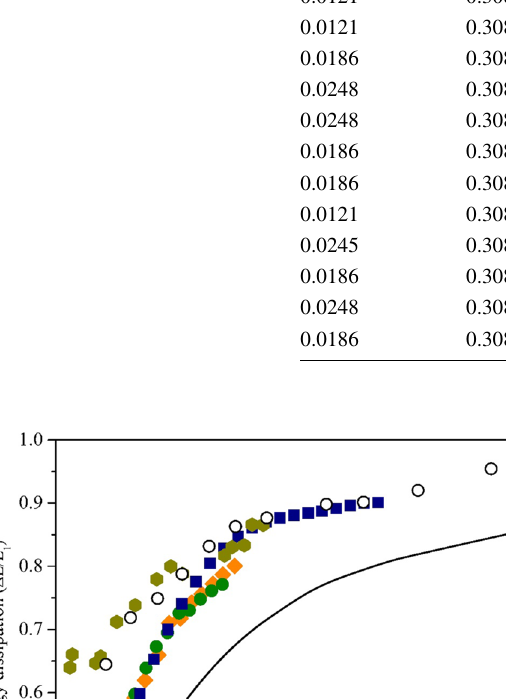
flow conditions for hydraulic jump studies